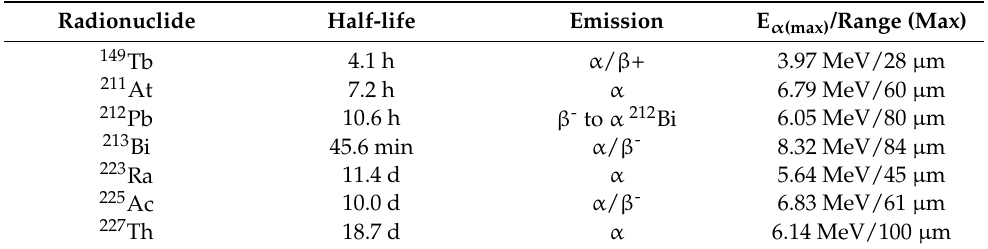
Table 3. α -Emitters employed in mCRPC treatment and their properties. Data extracted from